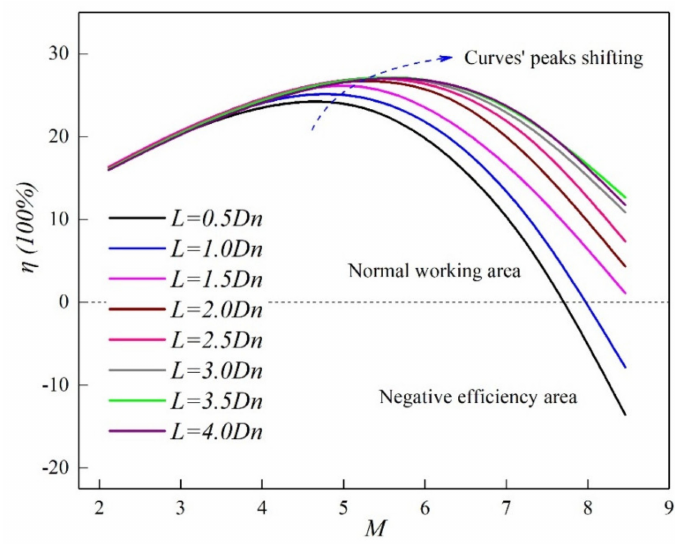
Figure 15. Efficiency curves at different mixing chamber lengths ( L = 0.5, 1.0, 1.5, 2.0, 2.5, 3.0, 3.5, 4.0 Dn